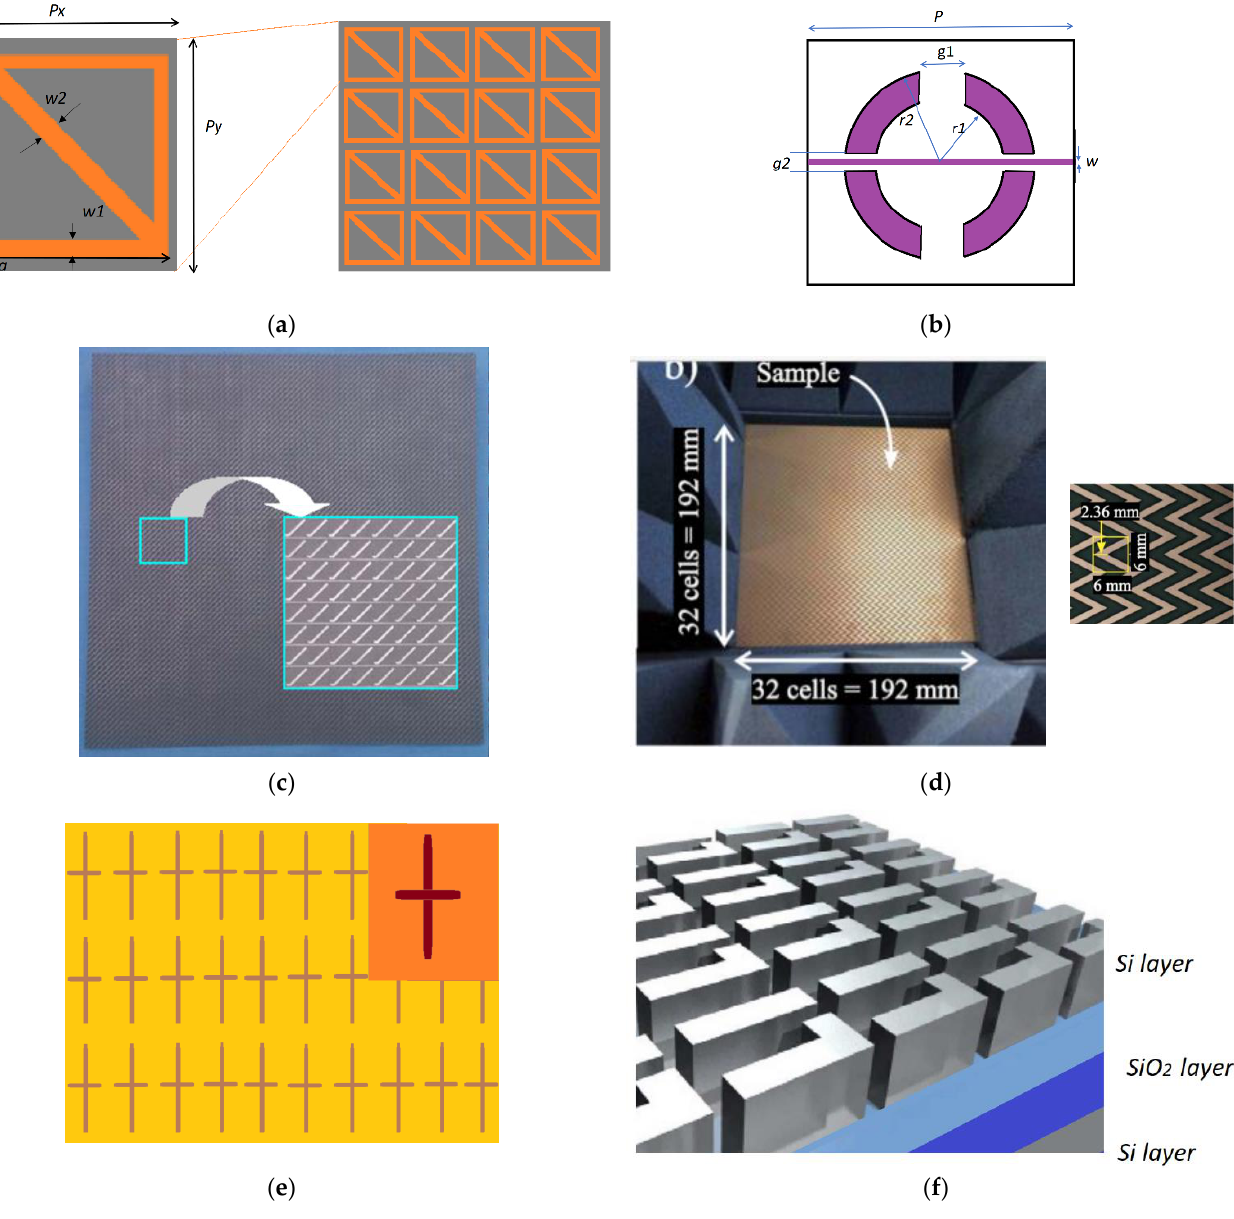
Figure 4. Different multi-layered single-band MSs ( a ) for linear to RHCP converter [67], ( b ) four-layered linear to circular polarization converter [68], ( c ) bi-layered polarization converter [69], ( d ) bi-layered zigzag structure, Reprinted, with permission [70], ( e ) bi-layered Babinet-inverted MSs [71], ( f ) Fano-resonant Si-MSs [72].